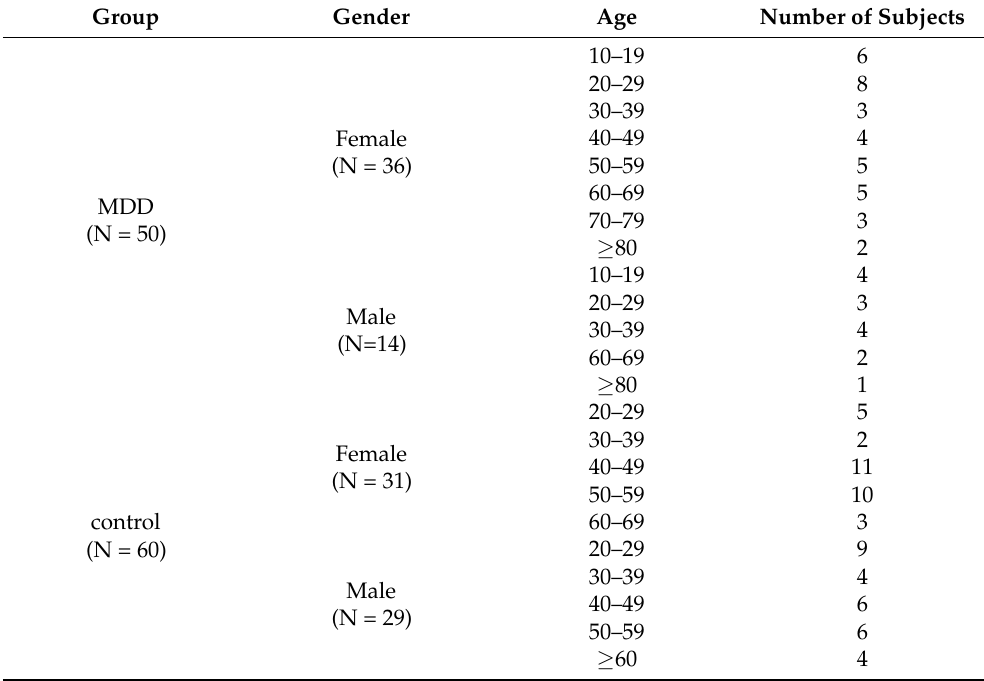
Table 1. Age and sex of the assessed study